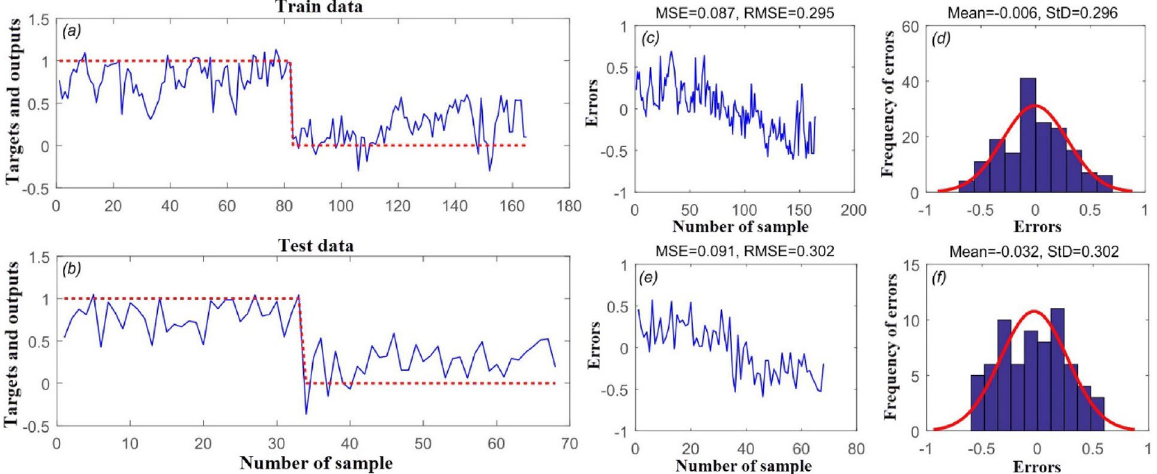
Figure 4. ( a ) Target and output SVR value of training data samples, ( b ) target and output SVR value of testing data samples, ( c ) mean squared error (MSE) and RMSE value of training data samples, ( d ) frequency of errors for training data samples, ( e ) MSE and RMSE value of testing data samples, and ( f ) frequency of errors for testing data samples.